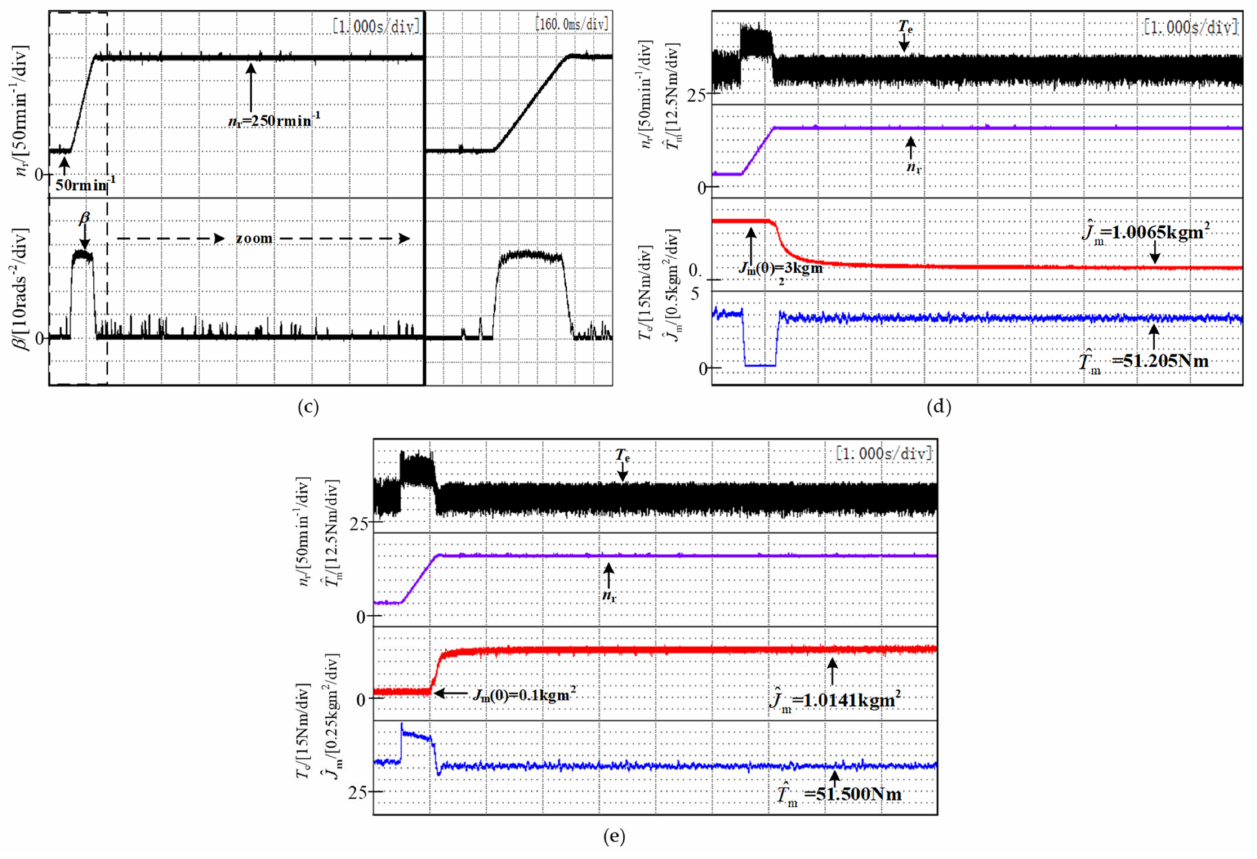
Figure 10. Experimental results with load torque of 50 Nm: ( a ) Three phase current and stator flux waveform; ( b ) Electromagnetic torque waveform; ( c ) Velocity and acceleration waveform; ( d ) Identification waveforms of moment of inertia and total load torque when J m (0) = 3 kg m 2 ; ( e ) Identification waveforms of moment of inertia and total load torque when J m (0) = 0.1 kg m 2.